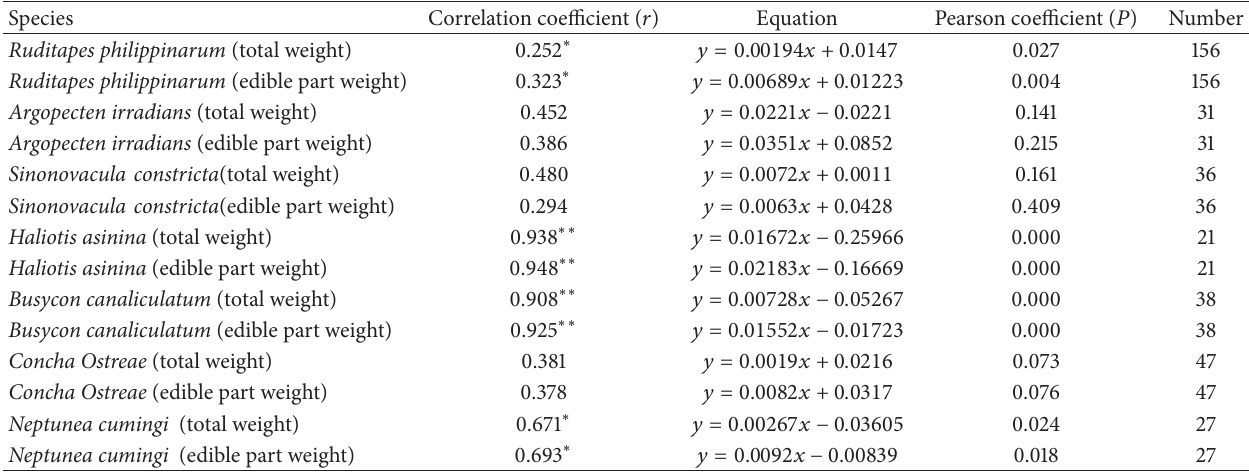
Table 3: Correlation between Hg content in different types of shellfish and their total weight/edible part weight.